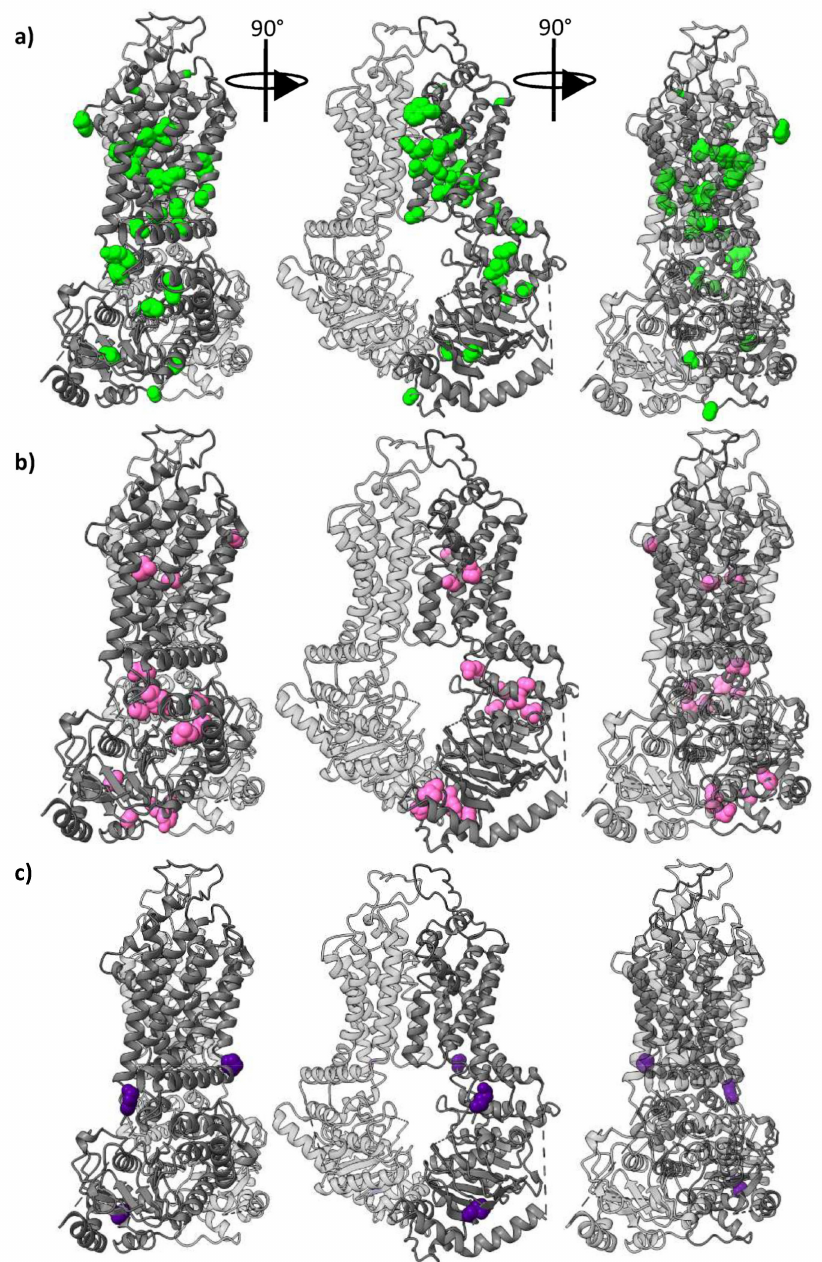
Figure 3. Functionally divergent residues shown on ABCG2 (PDBID: 6vxf) shown as coloured spheres on three views of the structure. ( a ) Residues conserved in the pattern (ABCG1, ABCG4), (ABCG2) (ABCG5), (ABCG8) as green spheres. ( b ) Residues conserved in the pattern (ABCG1, ABCG4), (ABCG2), (ABCG5, ABCG8) as pink spheres. ( c ) Residues conserved differently in each protein, i.e., with the conservation pattern (ABCG1), (ABCG4), (ABCG2), (ABCG5), (ABCG8) as purple